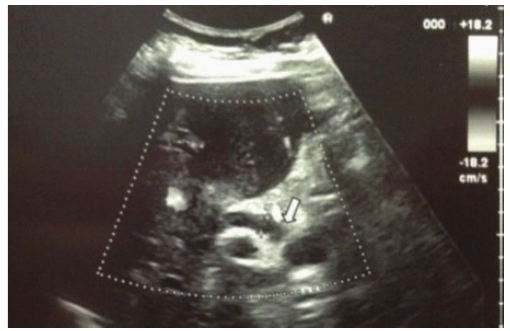
F 2: Abdominal ultrasound showing compression of the common hepatic duct which was dilated (8mm) in its extrahepatic tract above the level of the obstruction (white arrow) and not sonographically observable under the level of obstruction.